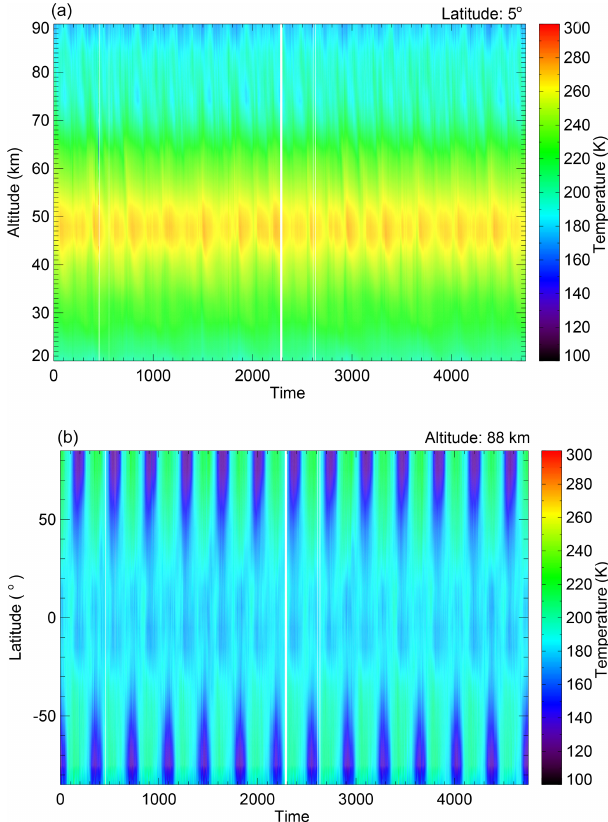
Figure 3. (a) The MLS temperature as a function of altitude and time day at 5 ◦ N. (b) The MLS temperature as a function of latitude and time at 88km altitude. The white lines indicate data